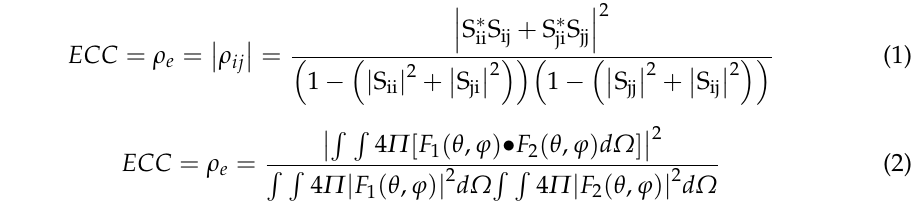
Figure 26. The simulated total and radiation efficiency of the MIMO antenna at port 1 with/without FSS.